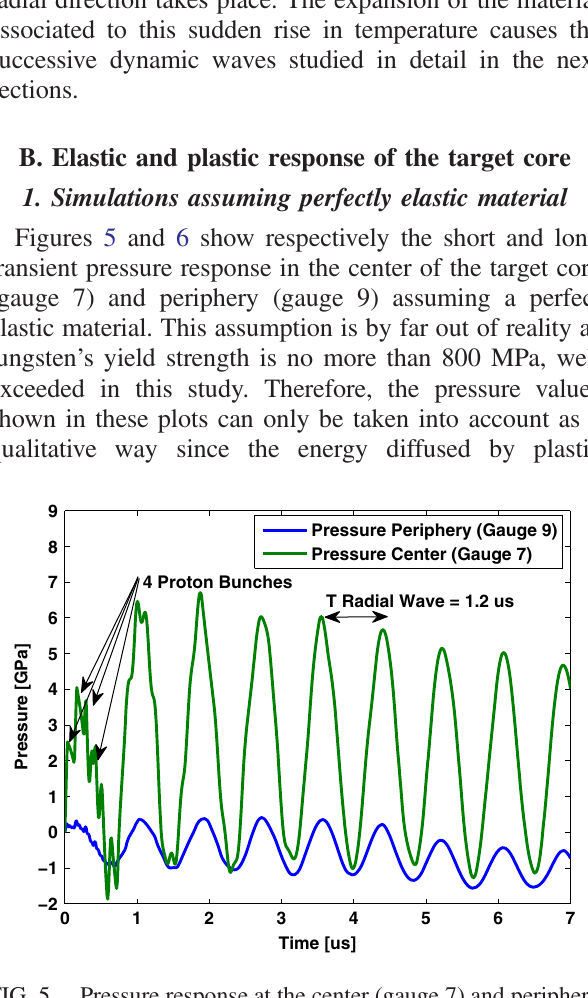
FIG. 5. Pressure response at the center (gauge 7) and periphery (gauge 9) during the first 7 μ s after the 430 ns -four bunches- proton pulse impact under infinitely elastic material assumption (reached pressures only for qualitative information). The plot clearly shows the existence of a radial wave with a 0 . 85 μ s period. Note that the oscillation takes place in phase in the center and periphery, meaning that the rod material simultaneously expands and contracts within its transversal